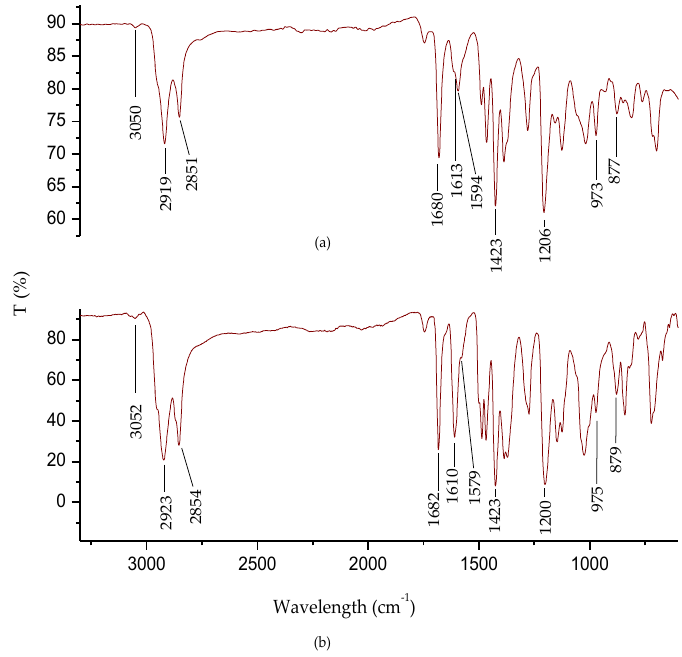
Figure 2. FT-IR spectra of the oligophenyleneimines: ( a ) DAFCHO; and ( b ) FDACHO.